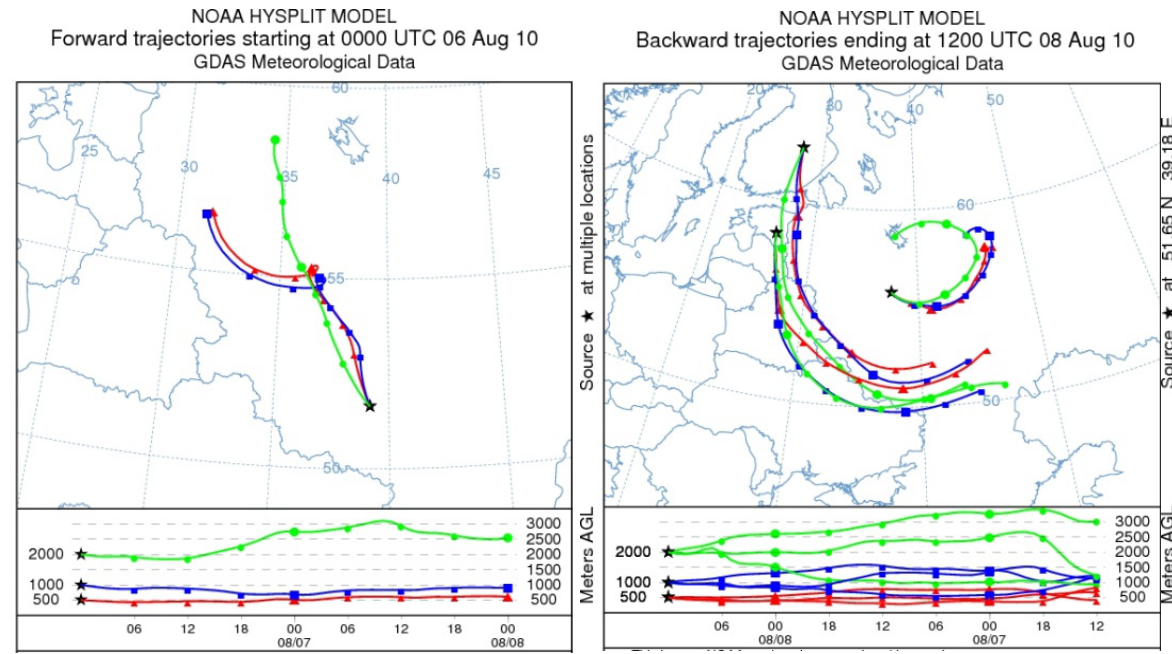
Fig. 6. Air flow trajectories for a 48h time interval with 6h temporal resolution obtained from the HYSPLIT model. Left: forward trajectories for air masses originating near the Voronezh Oblast starting on 6 August 2010 at 12:00 UTC; Right: backward trajectories of air masses reaching Moscow, Finland and Estonia on 8 August 2010 at 12:00 UTC. The bottom panels show the height of the air mass in meters above ground level.